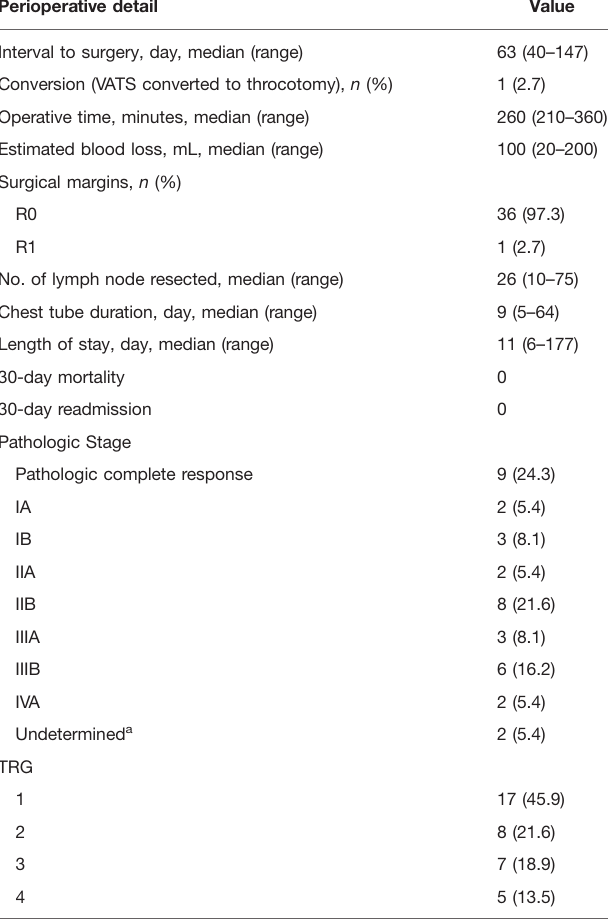
TABLE 2 | Perioperative outcomes of patients undergoing esophagectomy ( n =37). Perioperative detail